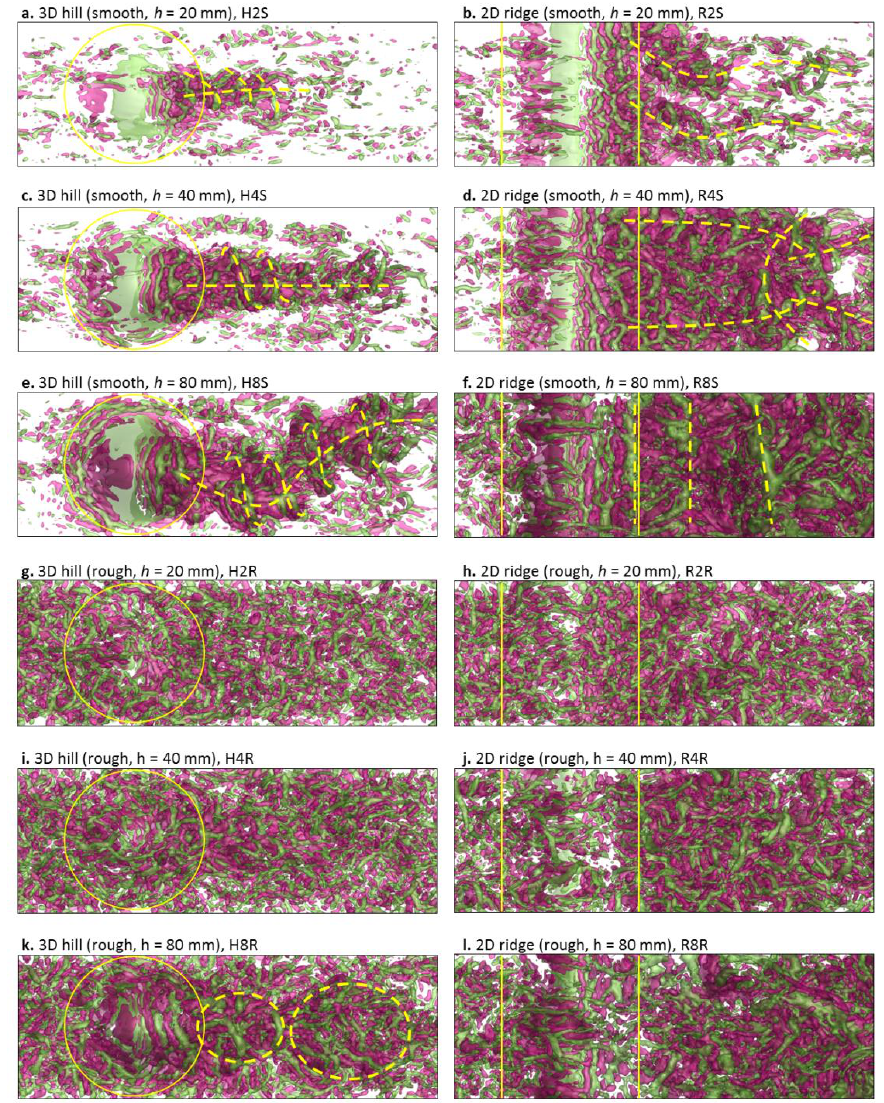
Figure 12. Instantaneous Q-criteria with values of 10000 ( purple ) and −10000 ( green ). The yellow solid lines indicate the location of the hills or ridges. The yellow dashed lines indicate the vortex cores in the wake of the topographies; ( a ) 3D hill (smooth, h = 20 mm),H2S, ( b ) 2D ridge(smooth, h = 20 mm),R2S, ( c ) 3D hill (smooth, h = 40 mm),H4S, ( d ) 2D ridge(smooth, h = 40 mm),R4S, ( e ) 3D hill (smooth, h = 80 mm),H8S, ( f ) 2D ridge(smooth, h = 80 mm),R8S, ( g ) 3D hill (rough, h = 20 mm),H2R, ( h ) 2D ridge (rough, h = 20 mm),R2R, ( i ) 3D hill (rough, h = 40 mm),H4R, ( j ) 2D ridge (rough, h = 40 mm),R4R, ( k ) 3D hill (rough, h = 80 mm),H8R, ( l ) 2D ridge (rough, h = 80 mm),R8R.